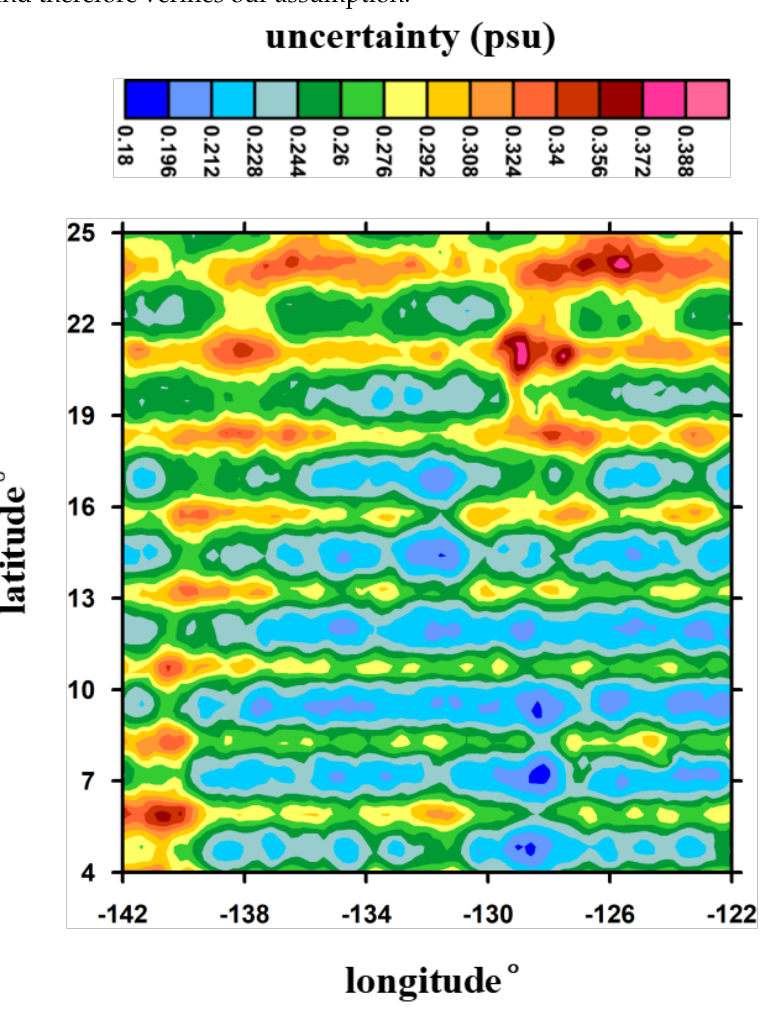
Figure 11. Sea surface salinity uncertainty of the tested region. Provided by BEC—Barcelona Expert Center, Spain. The image has been truncated into the tested